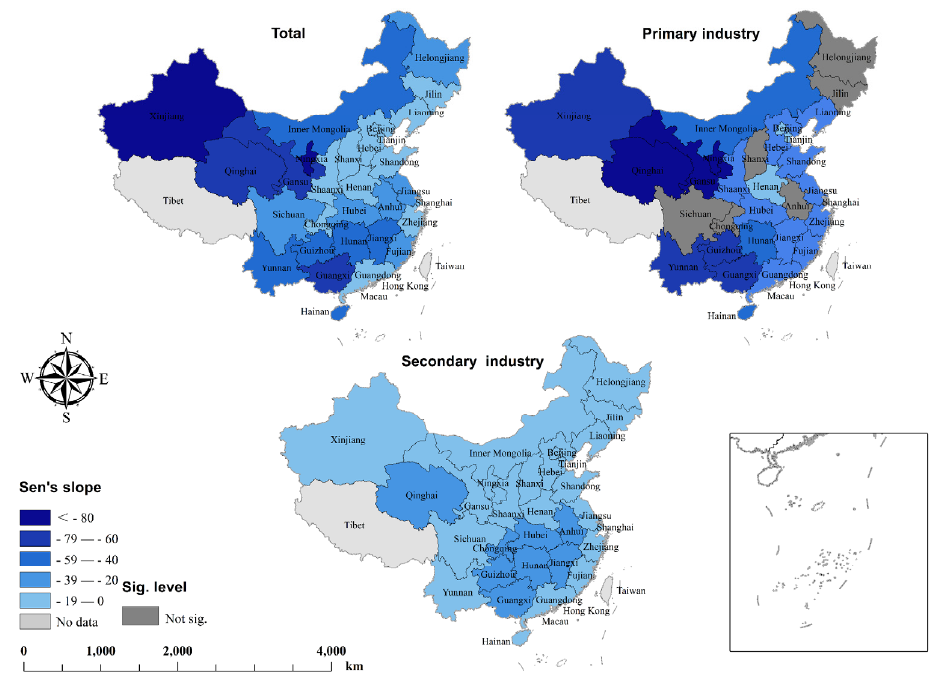
Figure 2. The magnitude of each trend and its statistical significance for China’s provincial water use intensity (WUI, m 3 /10 4 RMB) during the 2005 to 2015 period. Data are available in Tables A1–A3. From an industrial perspective, the average WUI values of PI and SI in urbanized regions declined from 673.41 m 3 /10 4 RMB and 132.90 m 3 /10 4 RMB, to 447.54 m 3 /10 4 RMB and 45.47 m 3 /10 4